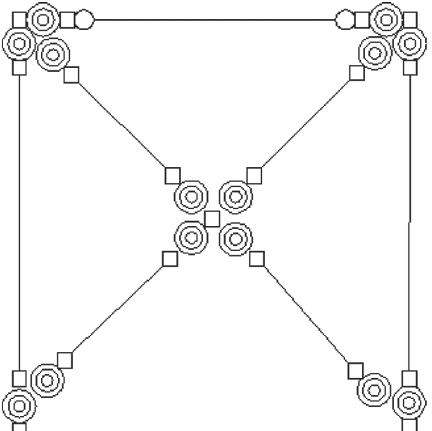
Figure 12: Mathematical model of a single bay concentric bracing Table 7, and for an example, the execution detail used for one of the link beams is shown schematically in Figure 14.